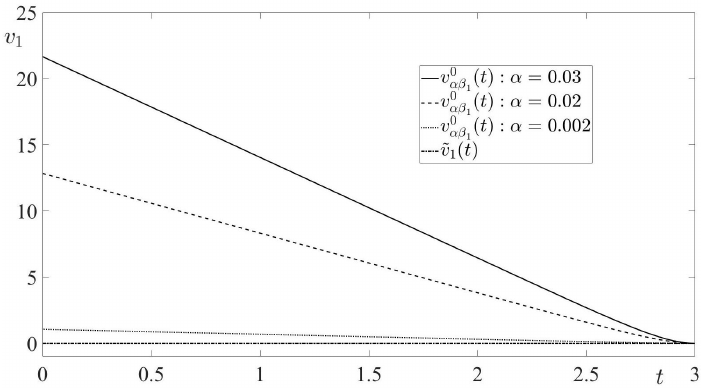
( t ) and limiting function ˜ v αβ 1